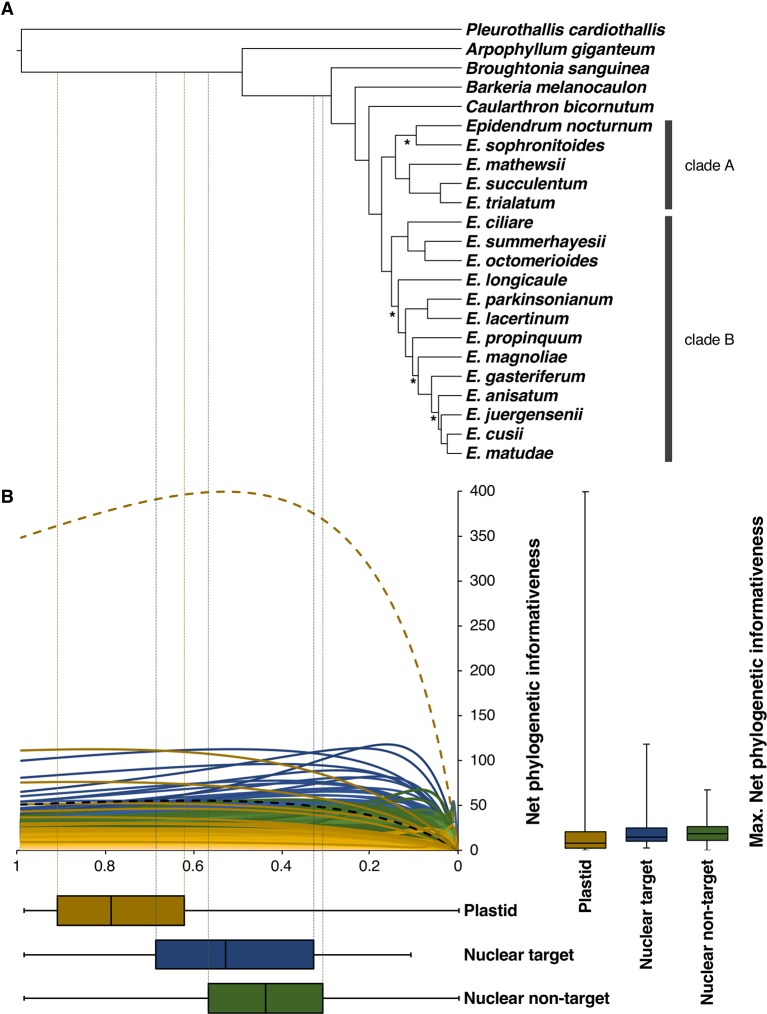

(A) Topology obtained in the nuclear SVDQuartets analysis with branch lengths optimized in RAxML and posteriorly converted to ultrametric (see Materials and Methods section). Nodes denoted by an asterisk (*) received BS < 85%. (B) Net phylogenetic informativeness profiles of nuclear target (light to dark blue), nuclear non-target (light to dark green), and plastid (light to dark yellow) partitions. Yellow and black dashed curves correspond to the ycf1 and matK genes, respectively, discussed in the main text. Distribution of loci maximum net phylogenetic informativeness values and time at which these values were reached is shown with quantiles 2 and 3 to the right and below the informativeness profiles, respectively. Whiskers denote maximum and minimum values. Time scale of the informativeness profiles match that of the ultrametric tree in (A). Vertical dotted lines denote the divergence times at which target (blue) and non-target (green) nuclear and plastid (yellow) partitions were more informative.